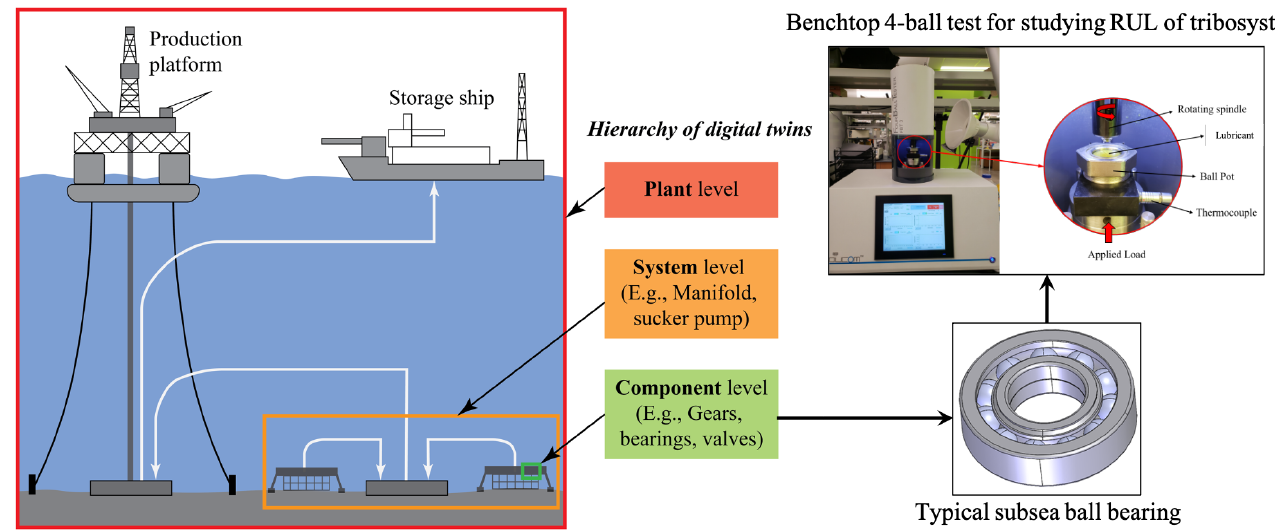
Figure 1. ( Left ) Schematic of a typical offshore oil and gas plant highlighting the digital twins. ( Middle ) The associated digital twins and their hierarchy. ( Right ) A typical subsea ball bearing and its benchtop equivalent in the form of a four-ball